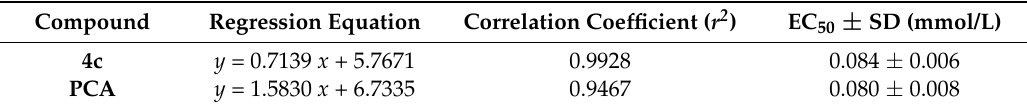
Table 2. In vitro fungicidal activities of compounds 4c and PCA against R. solani . Compound Regression